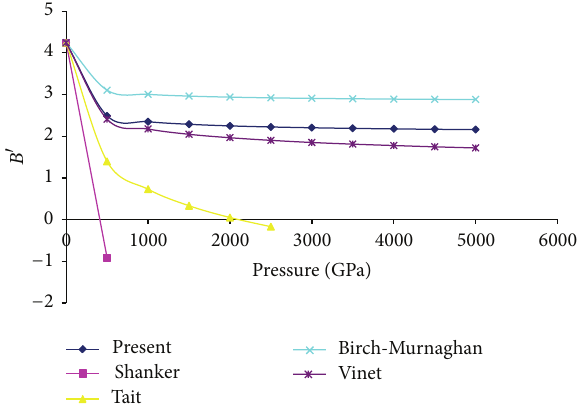
Figure 4: High pressure behavior of first order pressure derivative of bulk modulus using different